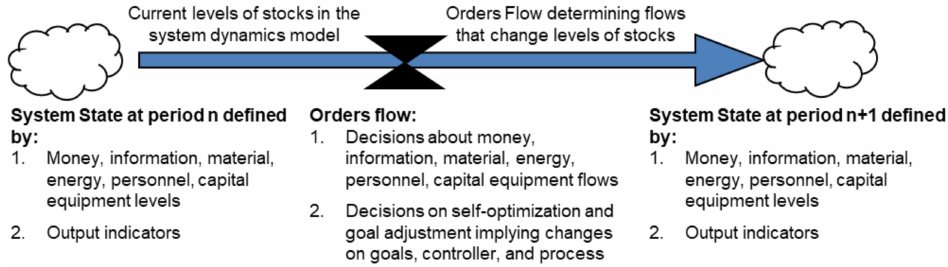
Figure 4. Manufacturing system state in different periods: decisions from stock and